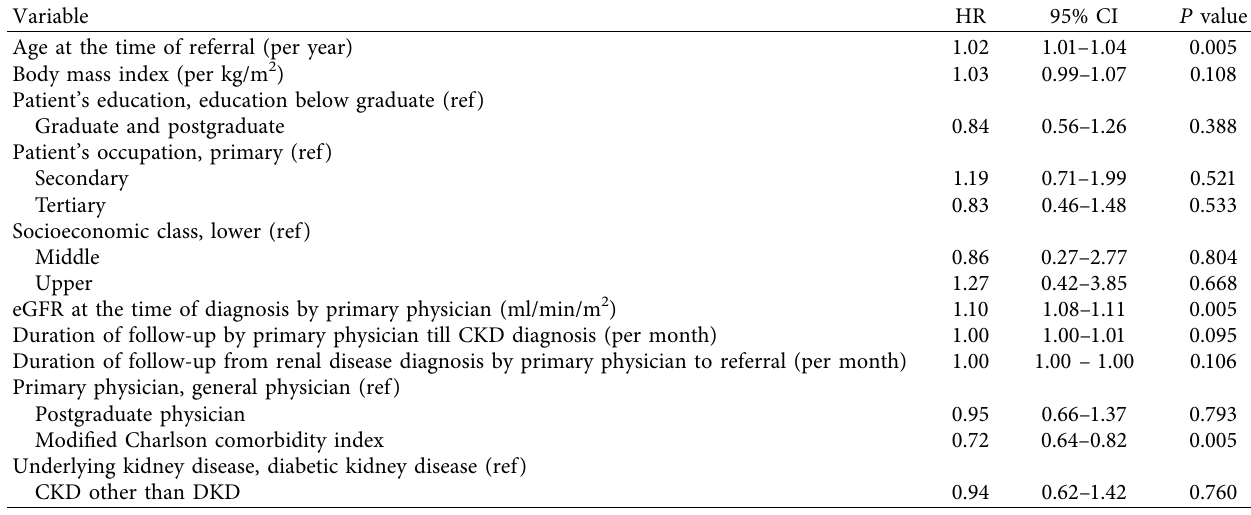
Table 3: Multivariate analysis showing variables associated with late